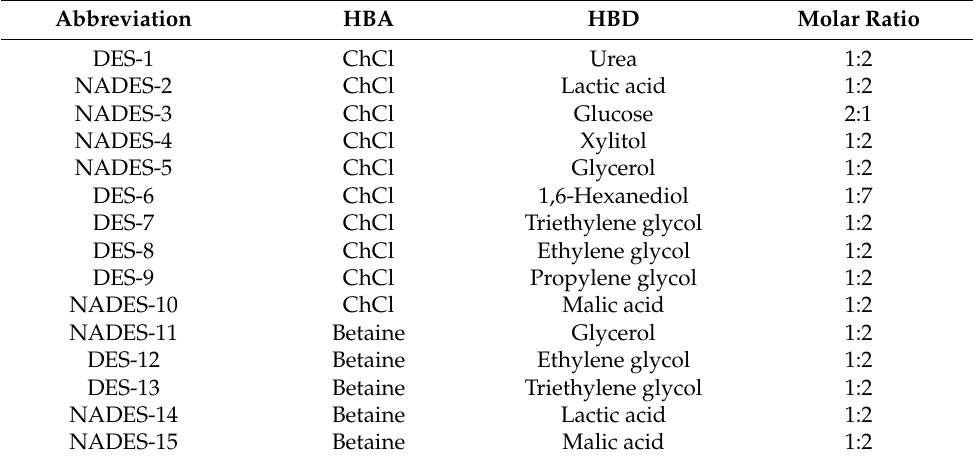
Table 1. List of the DESs and NADESs used in this study.